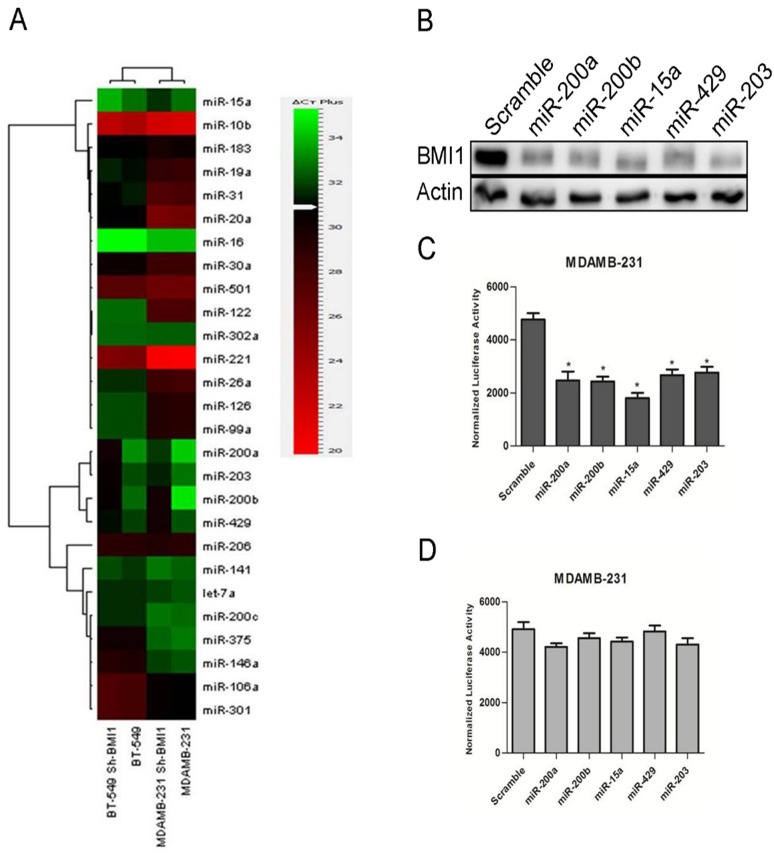
BMI1 regulated by miRNAs.Expression of the mentioned miRNAs in MDAMB-231 and BT-549 having pSMP-Bmi1 (A). Protein expression of BMI1wasanalyzed by performing western blotting in BT-549 cells having overexpressed miR-200a, miR-200b, miR-15a, miR-429, and miR-203. Actin was used as endogenous control (B).wt-BMI1 3’ UTR and Mut-BMI1 3’UTR were overexpressed along with miR-200a, miR-200b, miR-15a, miR-429, miR-203 and luciferase activity was measured (C,D).